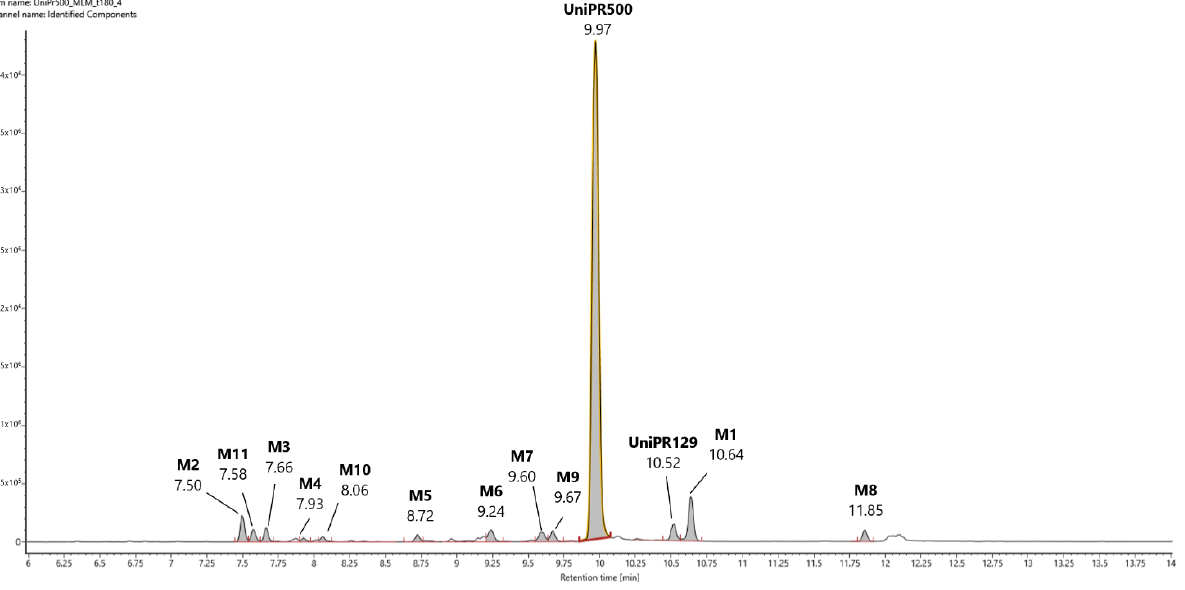
Table 3. Phase I putative metabolites of UniPR500 in mouse liver